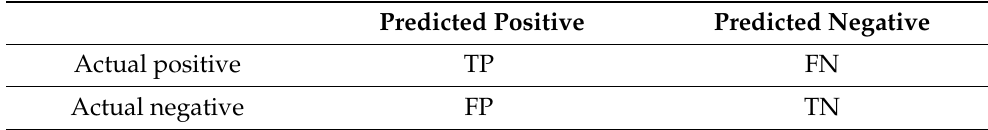
Table 4. Confusion matrix for two classes